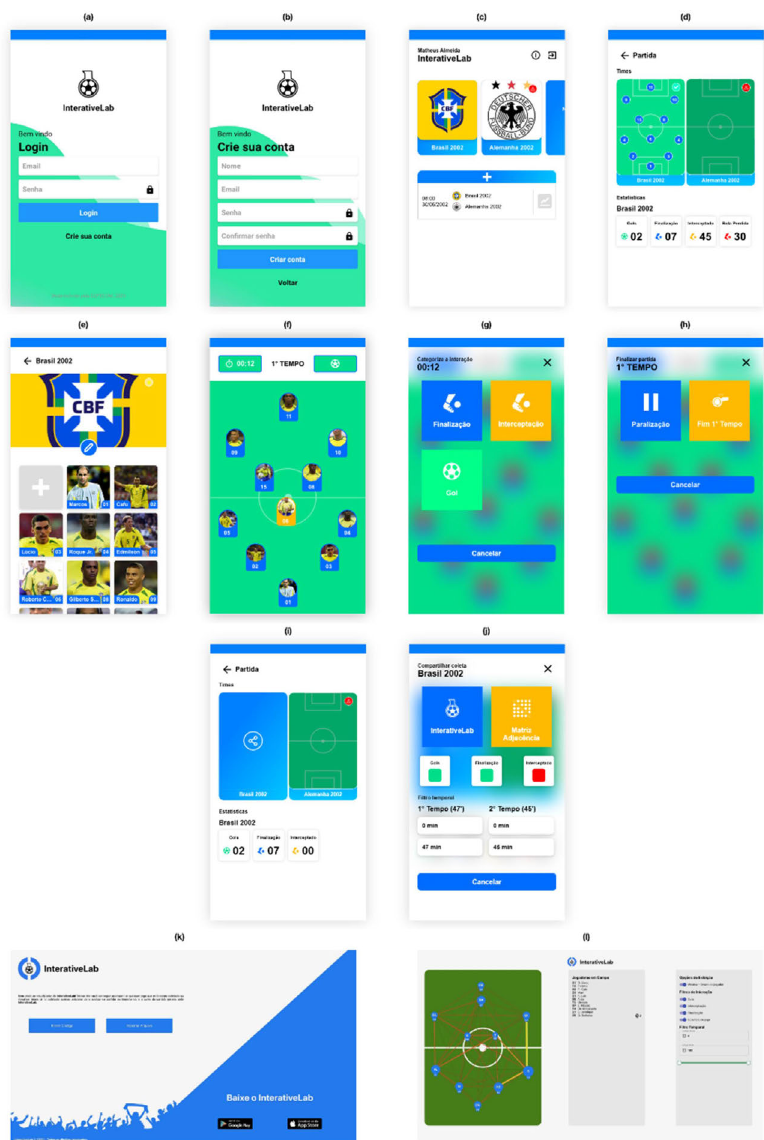
Figure 3 - Screens for ILab: (a) login, (b) account registration, (c) team registration, (d) matches registration, (e) players registration, (f) distribution of players in the collection environment, (g) the ratings of the Attack Units, (h) the screen for stopping or closing data collection, (i) sharing screen and pre- sentation of general game statistics, (j) screen to define parameters for viewing in Ilab or exporting data, (k) screen for entering the data identification code and starting the upload, and (l) real-time display screen with configuration options for